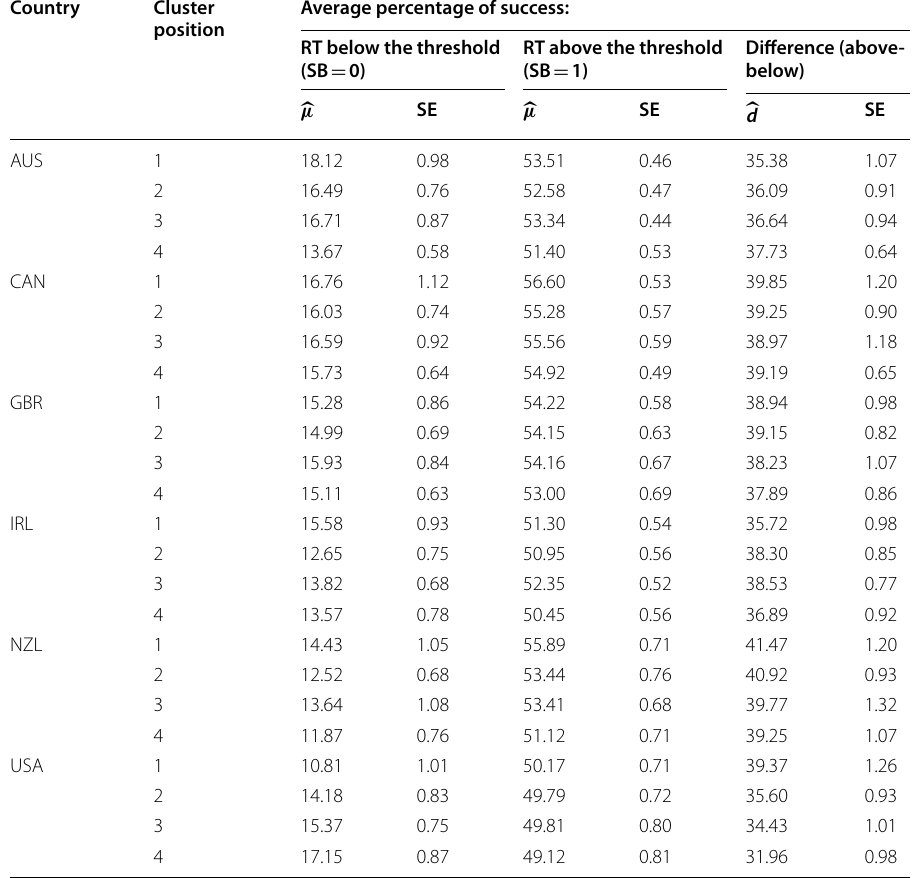
Table 4 At each cluster position, the average success percentage for responses where (i) SB SB 1 and (iii) difference in success percentages =